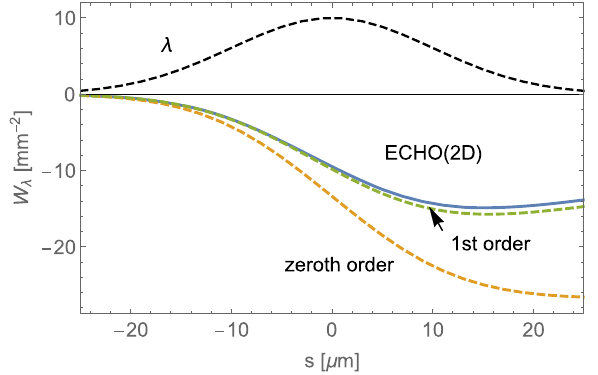
FIG. 6. Longitudinal bunch wake for a Gaussian beam with σ ¼ 10 μ m offset in the RadiaBeam/LCLS dechirper. The offset z is y ¼ 0 . 5 mm and the half-aperture is the nominal a ¼ 0 . 7 mm. Given are the numerical results of ECHO(2D) (blue), and the analytical zeroth order (red) and 1st order results (green). The bunch shape λ ð s Þ with the head to the left is shown in